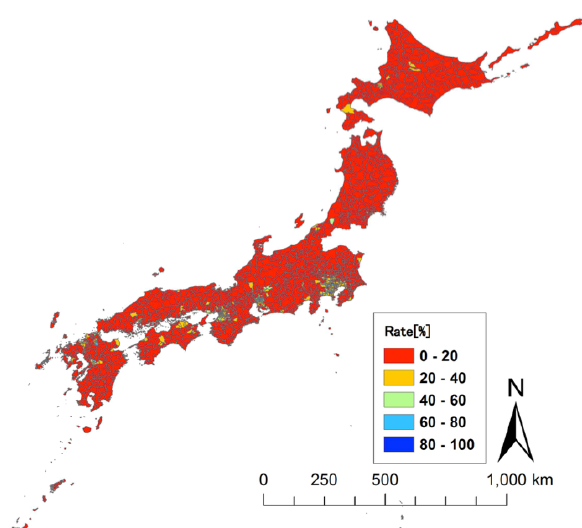
Figure 7. Rates of convenience stores that satisfy the survival conditions in